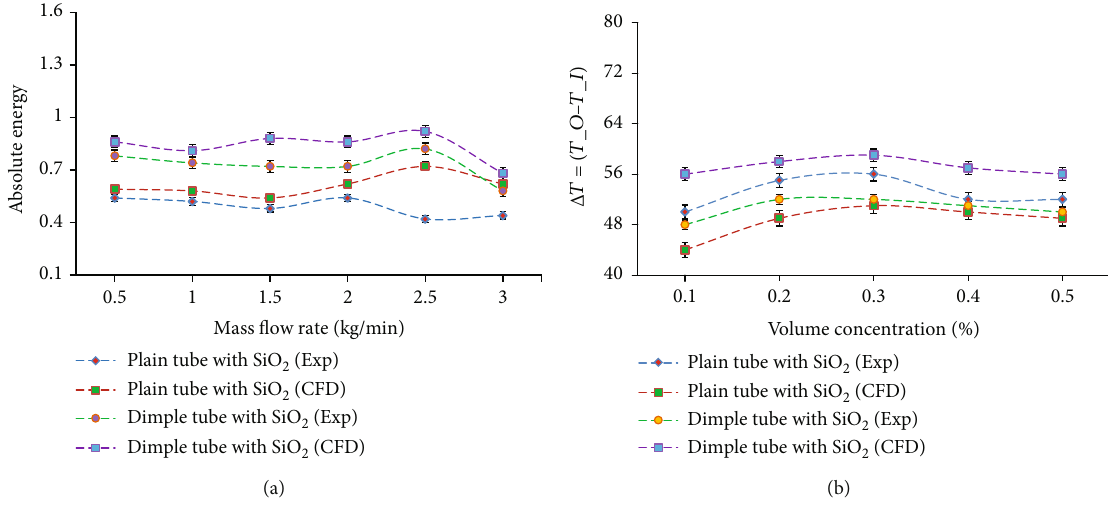
Figure 7: (a) Mass fl ow rates vs. absolute energy parameter. (b) Volume concentration vs. heat